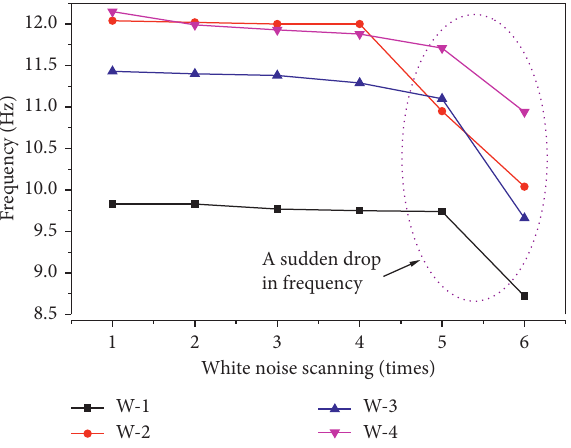
Figure 9: Natural frequency of the wall.